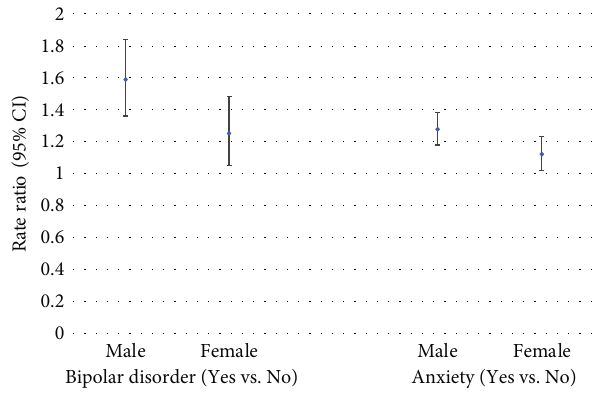
Figure 3: Increased rate of injury for comorbid bipolar disorder and anxiety among ADHD cases by